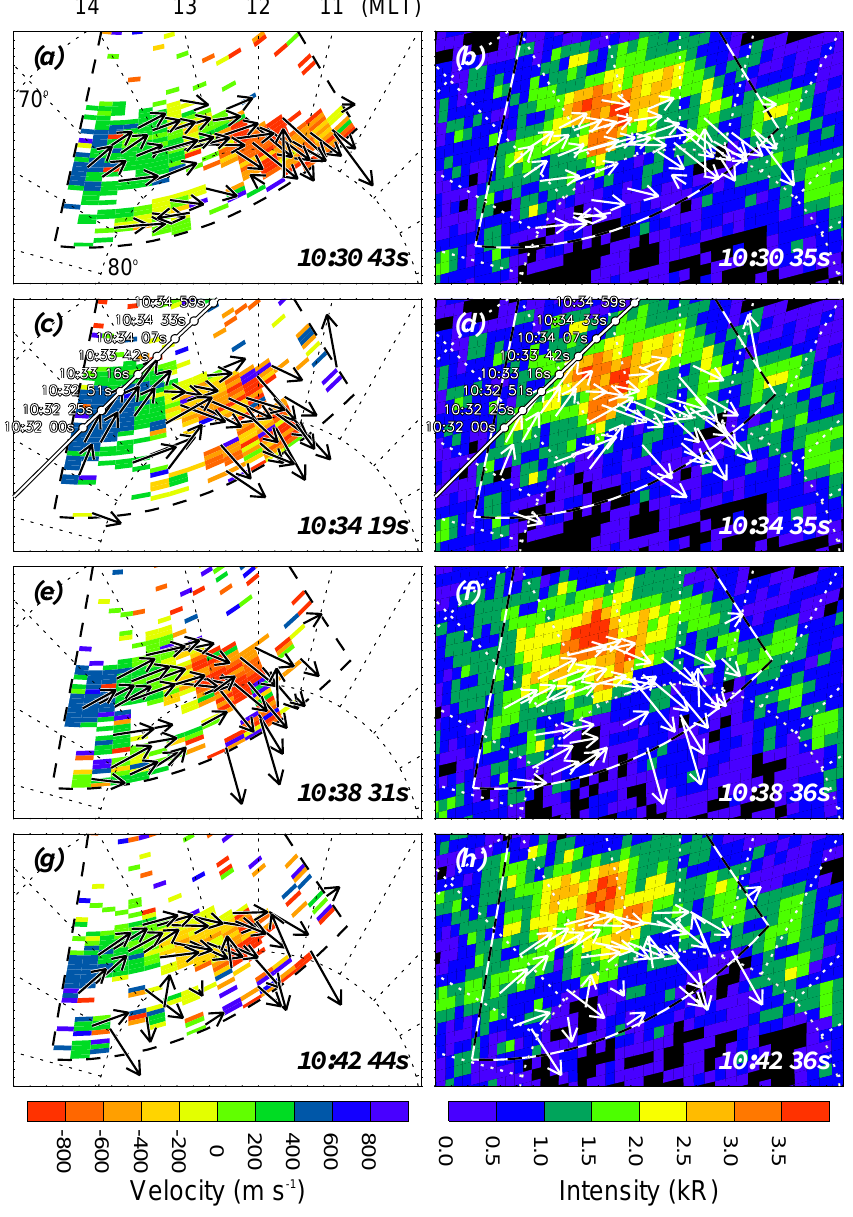
Fig. 3. CUTLASS Hankasalmi line-of- sight velocity scans and Polar VIS im- ages for the interval 1030:43–1042:44 UT. Format as for Fig. 2. The footprint of a DMSP overpass is also shown in panels c and